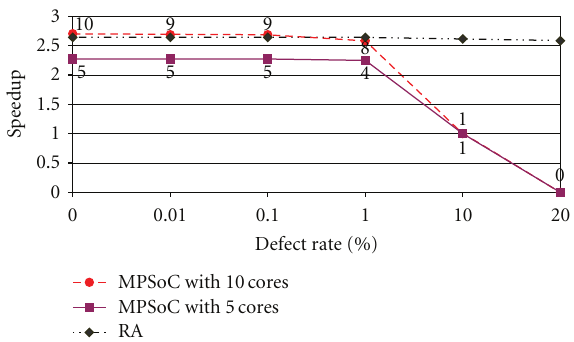
Figure 16: Defects simulation in the MPSoC—simulations per- formed on a 10-core MPSoC and no fault tolerance solution, on a 10-core MPSoC and 3ALUs per core, and on a 5-core MPSoC with two processors per core. All cores fail under 15% defect rate.